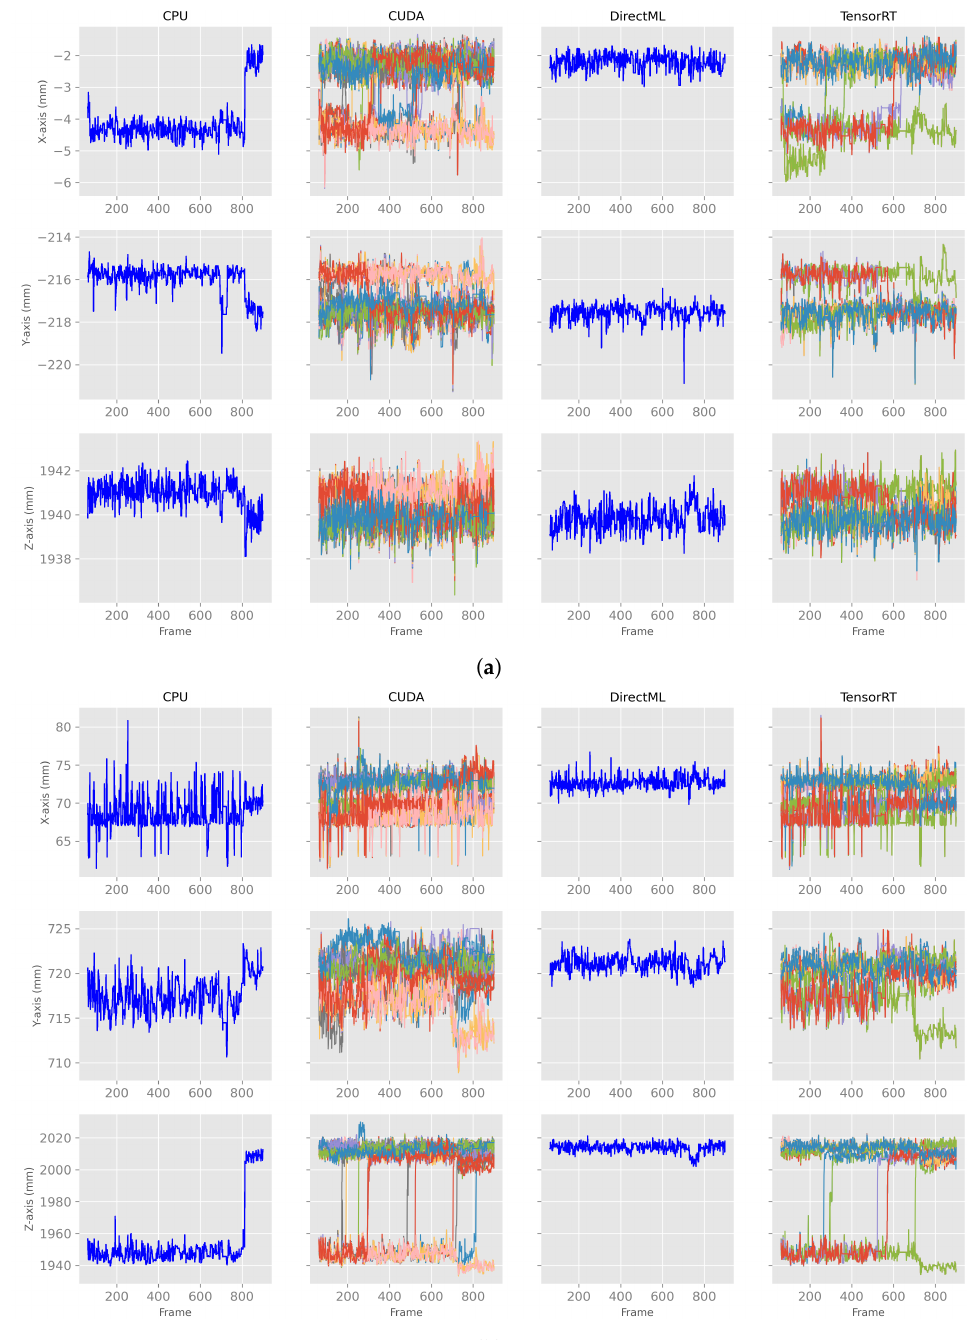
Figure A1. X -, y -, and z -axes of the joint positions of PELVIS and FOOT_LEFT for all four processing modes on computer A. ( a ) X -, y -, z -axes for the joint position of PELVIS. ( b ) X -, y -, z -axes for the joint position of